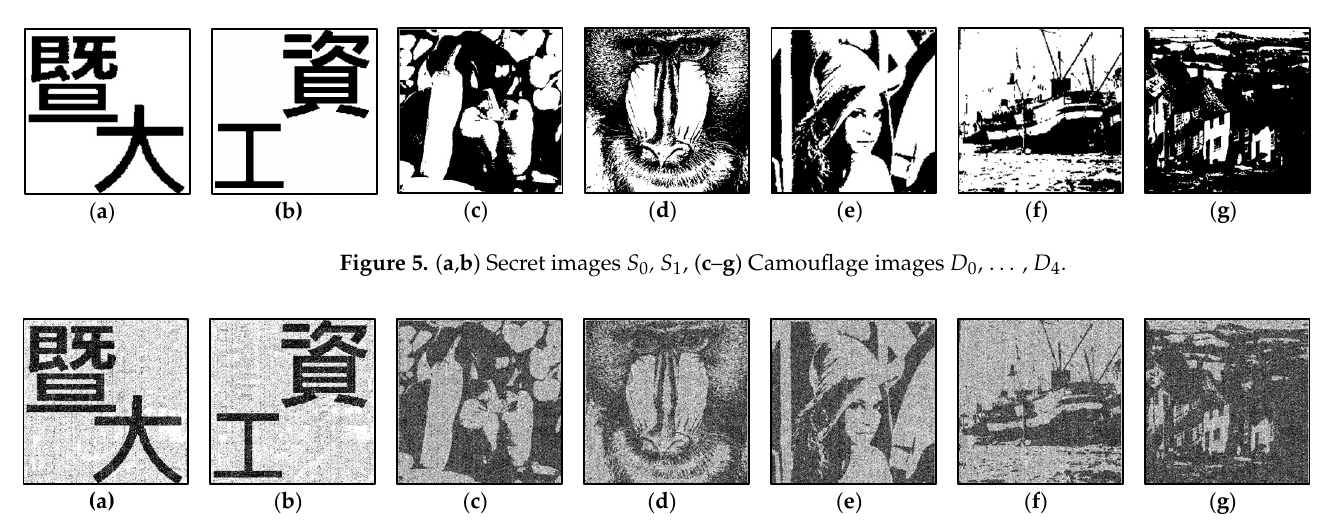
Figure 6. Experimental results by Method 1 for (5, 5) with p = 45, γ = 0.5. ( a , b ) Restored images R 0 , R 1 , ( c )–( g ) Shares M 0 , …, M 4 .